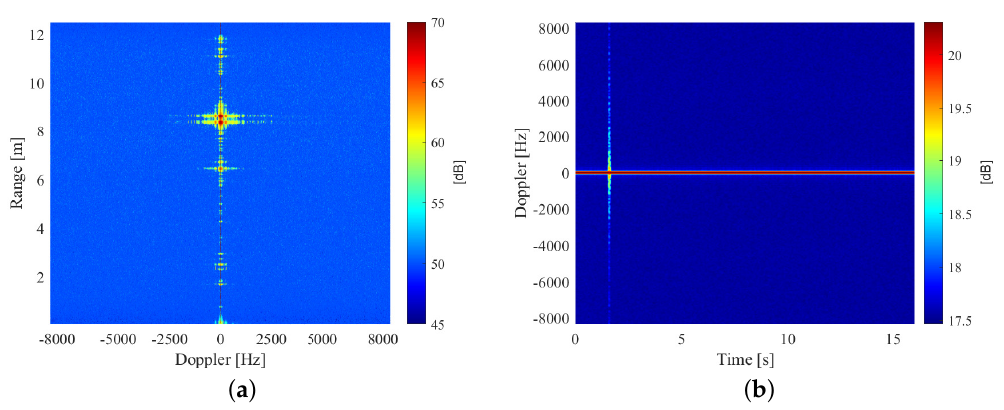
Figure 7. Analysis on the background in absence of subjects using ( a ) Range-Doppler map and ( b ) Doppler-Time